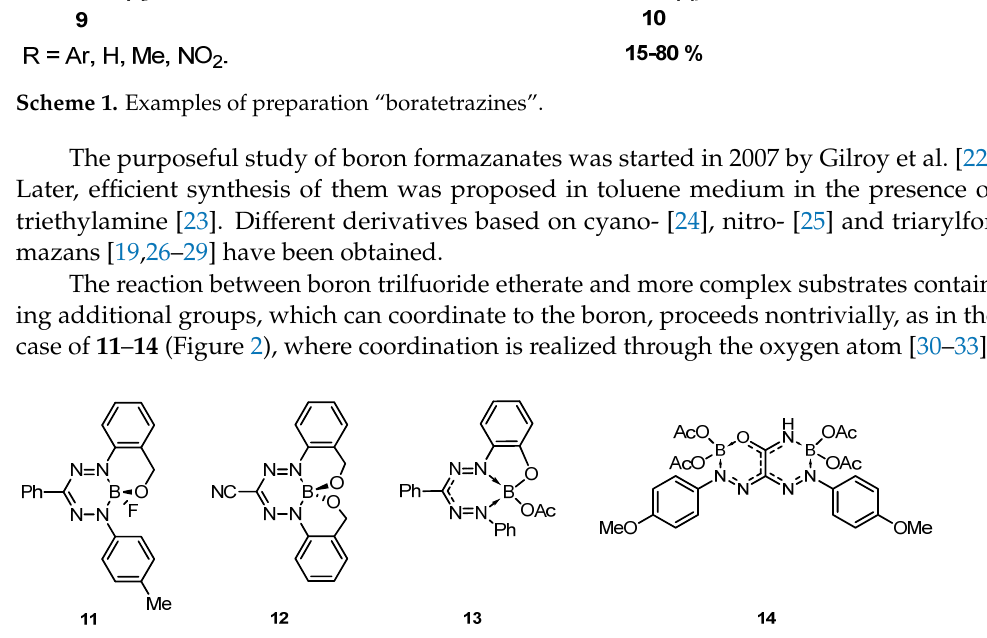
Figure 2. Examples of various boron formazanates.